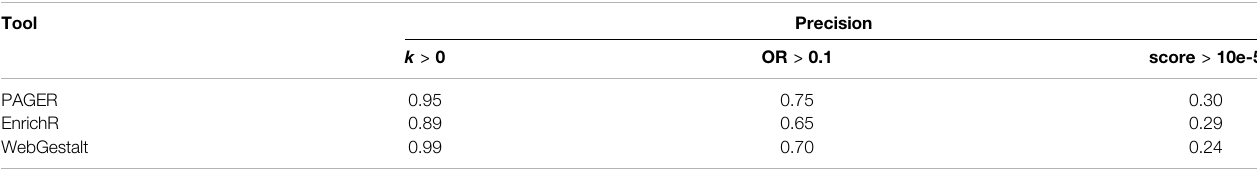
TABLE 5| Theperformanceofthethree tools. k represents thecitationsof “ melanoma ” andthekeywordsfromapathway. OR representstheoddsratio. Score represents the PubMed score .